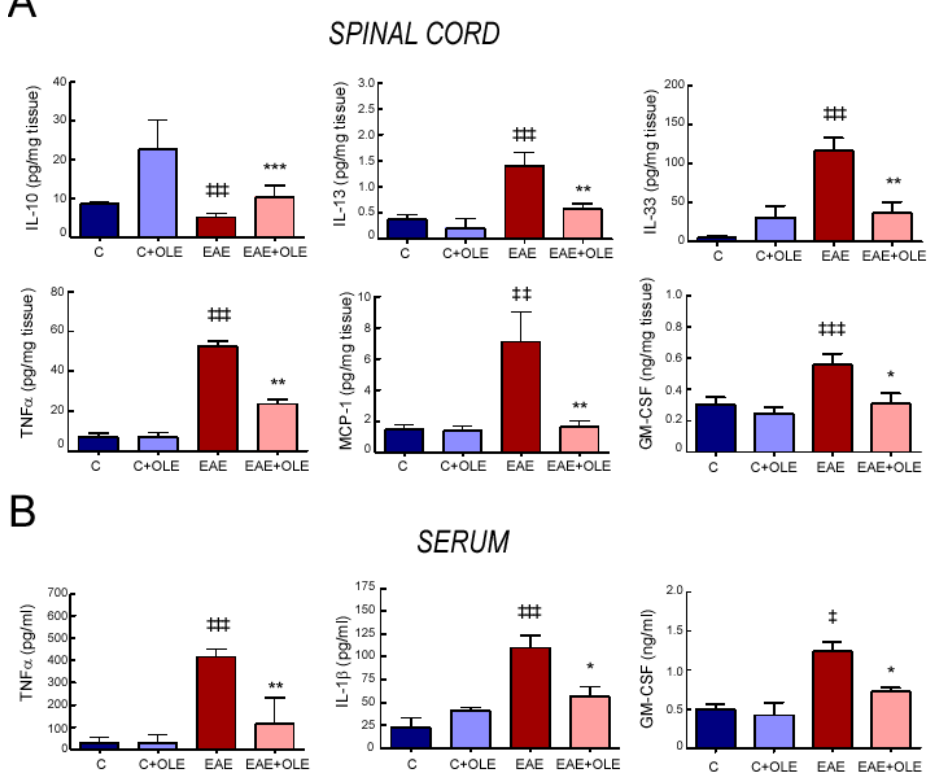
Figure 4. Oleacein treatment modulates production of inflammatory markers in EAE mice. Spinal cord ( A ) and serum ( B ) from control and EAE mice treated with vehicle or OLE were analyzed at day 23 post-immunization. Protein levels of GM-CSF, IL-13, IL-33, TNFα, MCP-1, IL-10 and IL-1β were quantified by commercial ELISA. Bar graphs represent the mean ± SEM of 5–8 animals, from two independent experiments.). ‡‡‡ p < 0.001, ‡‡ p < 0.01 and ‡ p < 0.05 vs. control; and *** p < 0.001, ** p < 0.01 and * p < 0.05 vs. EAE.